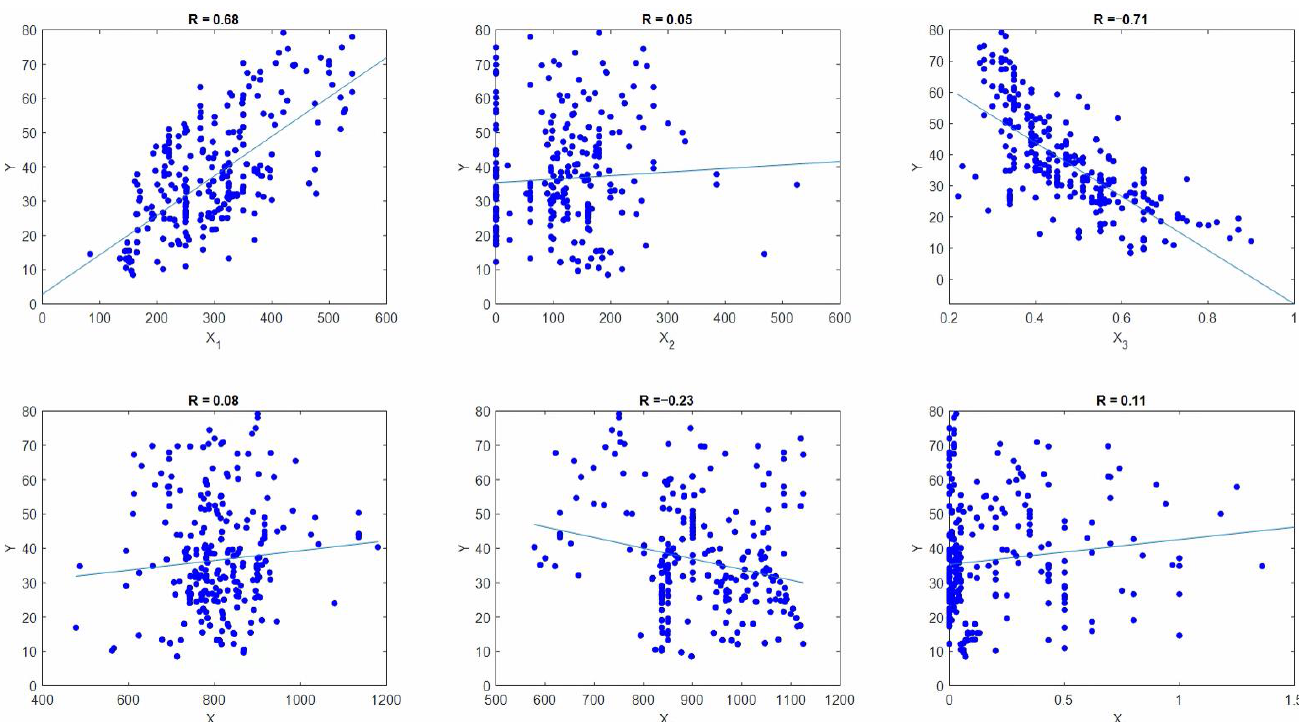
Figure 2. Scatter plots of variables in Dataset 2.